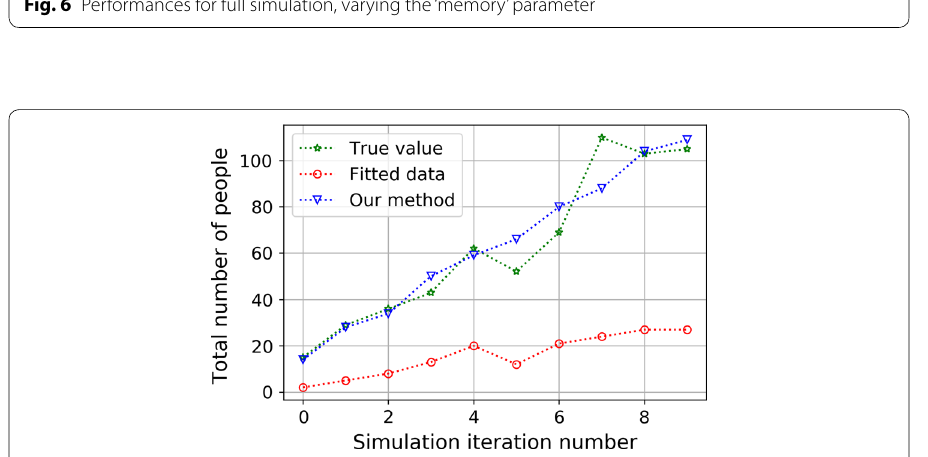
Fig. 7 Performances for the ‘static’ crowd